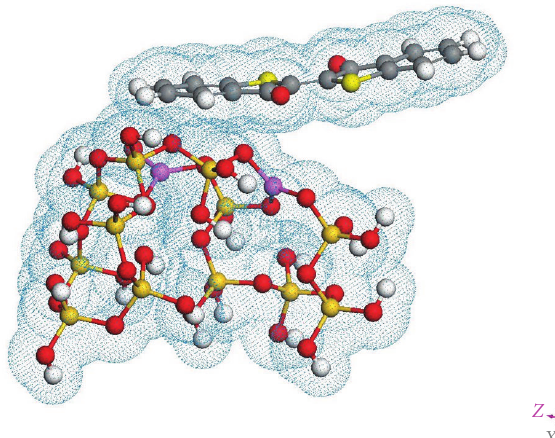
Figure 8: Optimized thioindigo/sepiolite structure with Van der Waals surface displayed. Note the distortion of the planar geometry of the thioindigo